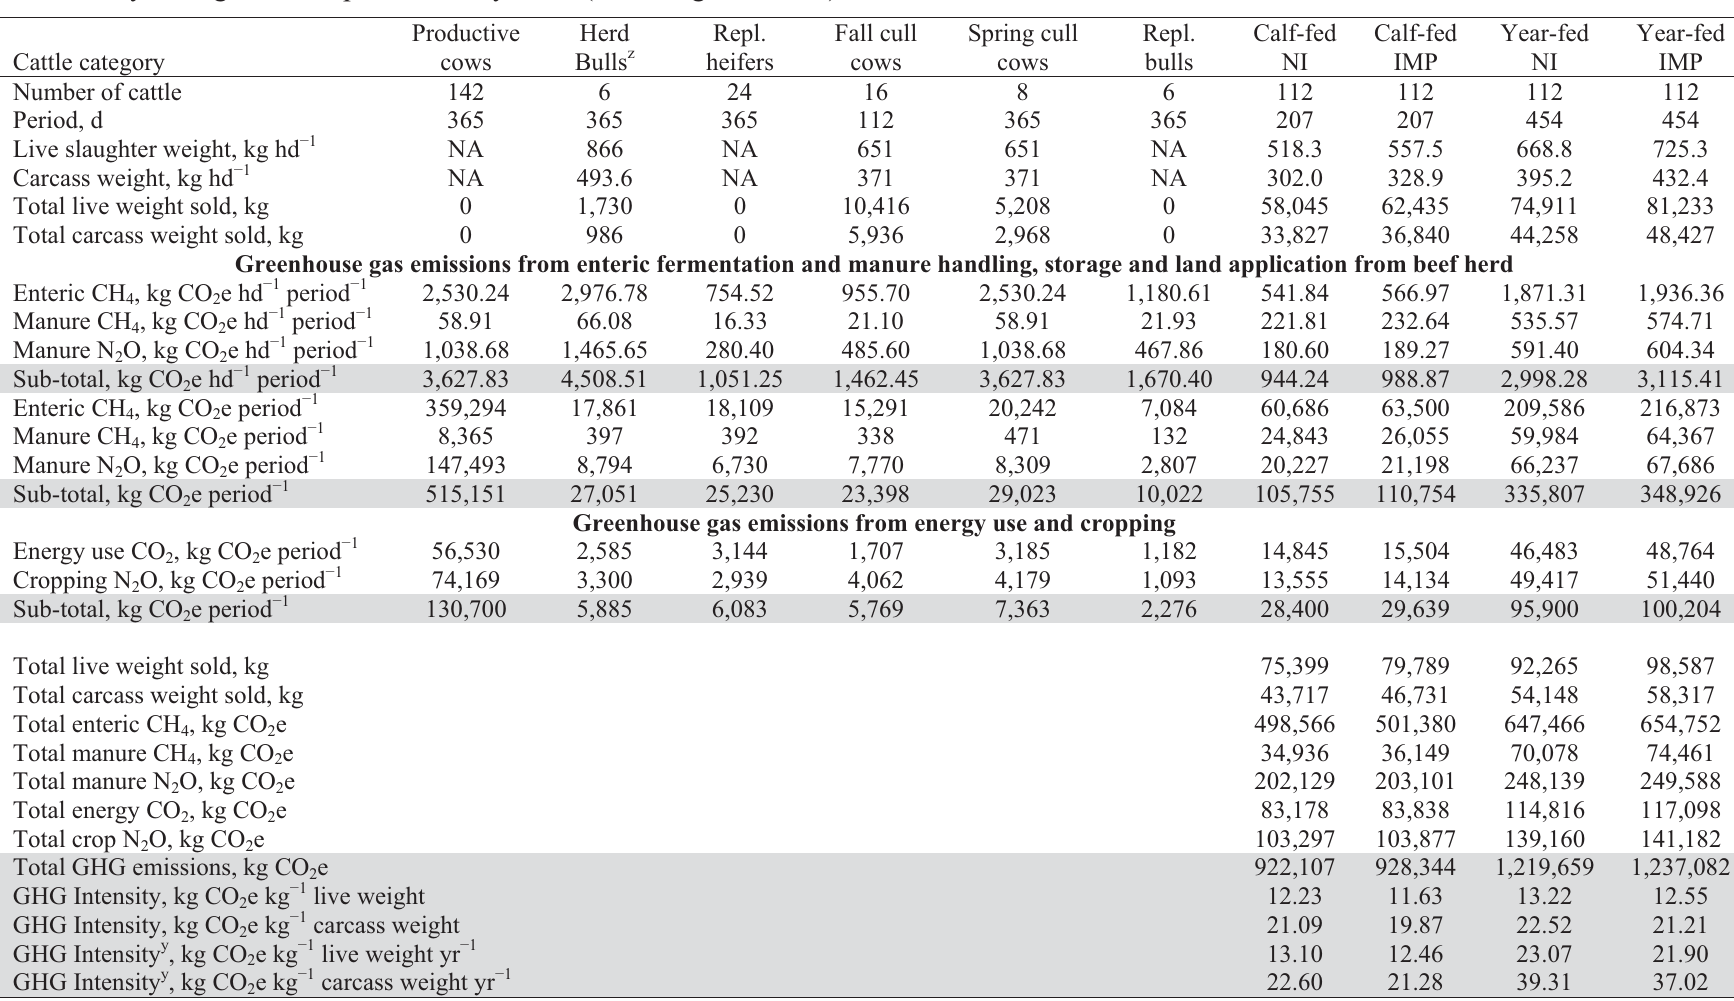
Table A7. Greenhouse gas emission by cattle category and source, and overall GHG intensity for non-implanted (NI) and implanted (IMP) calf- and yearling-fed beef production systems (assuming 160 cows) y . Cattle category